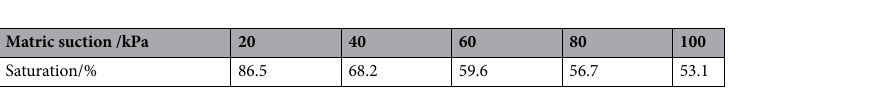
Table 2. The measured matrix suction and its corresponding